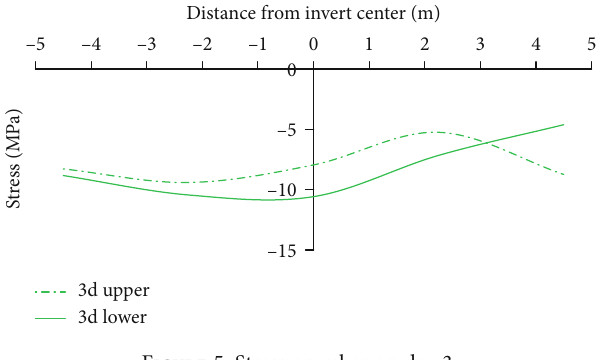
Figure 5: Stress on rebar on day